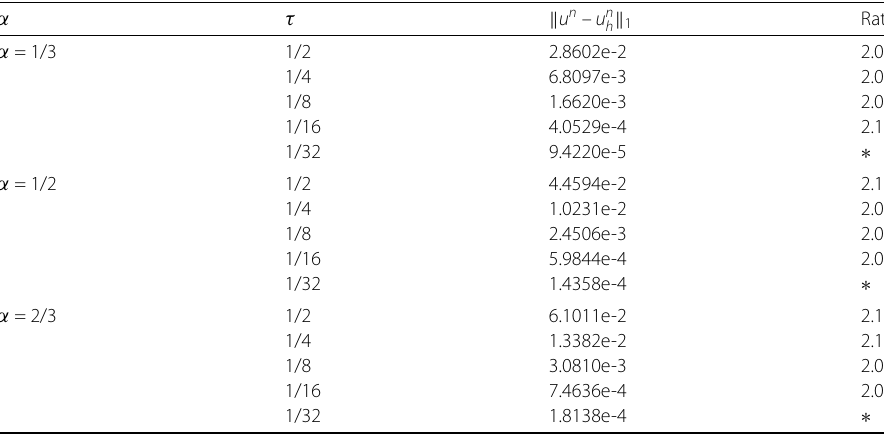
Table 4 Numerical errors and convergence orders in temporal direction with h = π T = 1 for Example 2